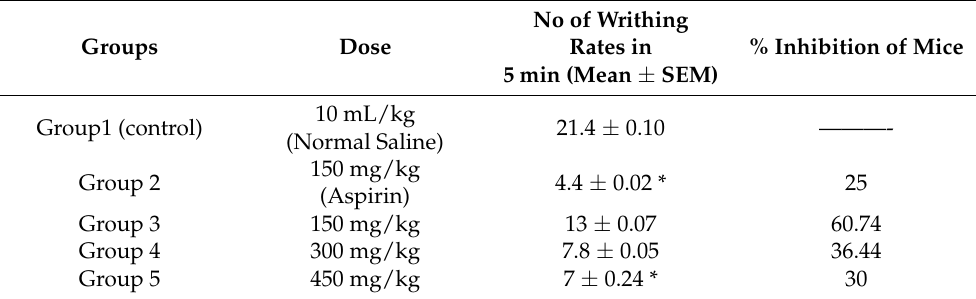
Table 1. Analgesic potential in methanolic extracts of different doses. All treatments consist of 5 groups. Each group has 3 replicates and was treated with different doses. The expression of value was mean ± SEM based. The mean difference was considered statistically significant at the 0.05 level. Significance indicated (* p < 0.05).